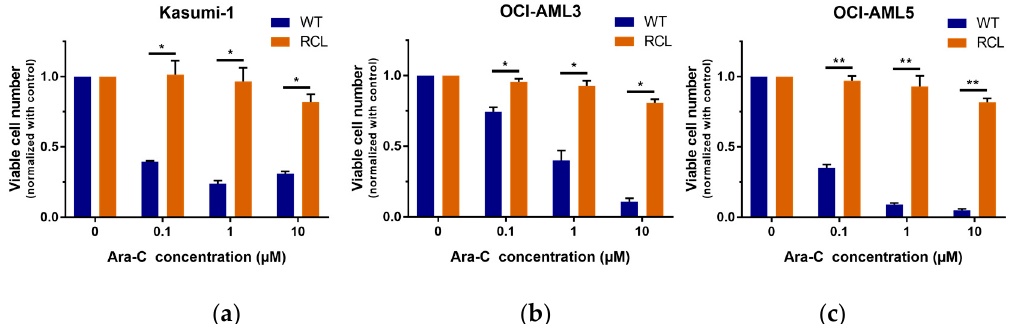
Figure 1. Number of viable cells in resistant vs. parental cell lines following treatment with increasing cytarabine (Ara-C) concentrations. Resistant cell lines (RCL) and wildtype (WT) variants of acute myeloid leukemia (AML) cell lines Kasumi-1 ( a ), OCI-AML3 ( b ), OCI-AML5 ( c ) were plated with different concentrations of Ara-C ranging from 100 nM to 10,000 nM. Cell counts were normalized to the those in untreated controls. The average number of viable cells (Ø) in the untreated control samples was 1.00 × 10 6 (Kasumi-1), 1.54 × 10 6 (OCI-AML3), and 1.43 × 10 6 (OCI-AML3) for WT cells and 1.96 × 10 6 (Kasumi-1), 1.92 × 10 6 (OCI-AML3), and 1.75 × 10 6 (OCI-AML3) for RCL; * p < 0.05 and ** p < 0.01 in Welch’s t -test.